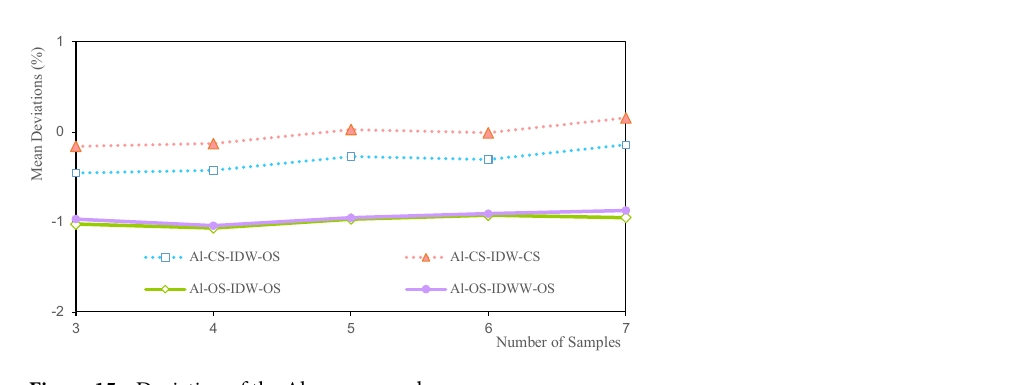
Figure 15. Deviation of the Al average